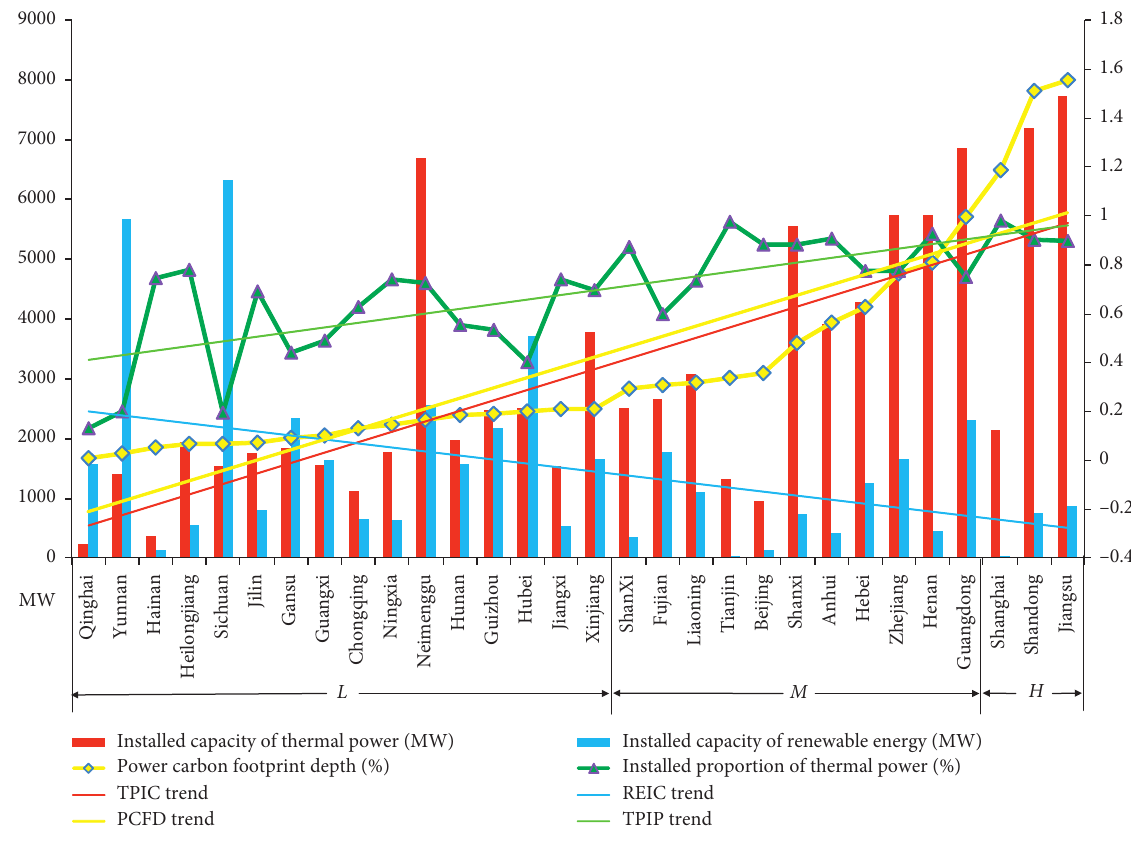
Figure 7: Power installation scale of China’s provinces in